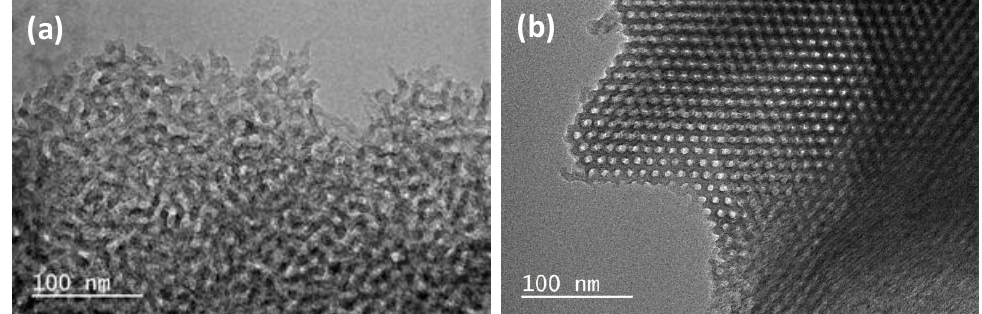
Figure 9. TEM images of carbon materials obtained in the absence ( a ) and presence ( b ) of Figure 9. phloroglucinol.